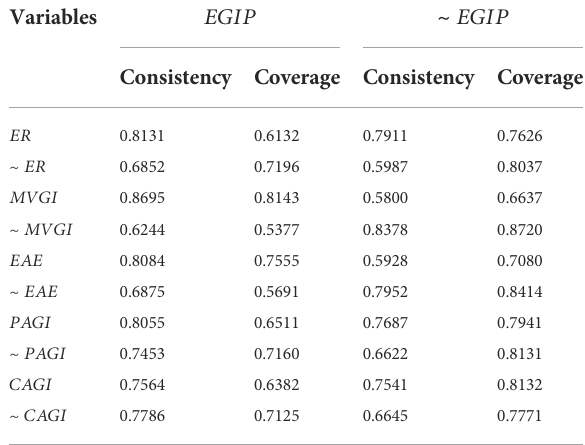
TABLE 2 NCA method bottleneck level (%) analysis results a . EGIP